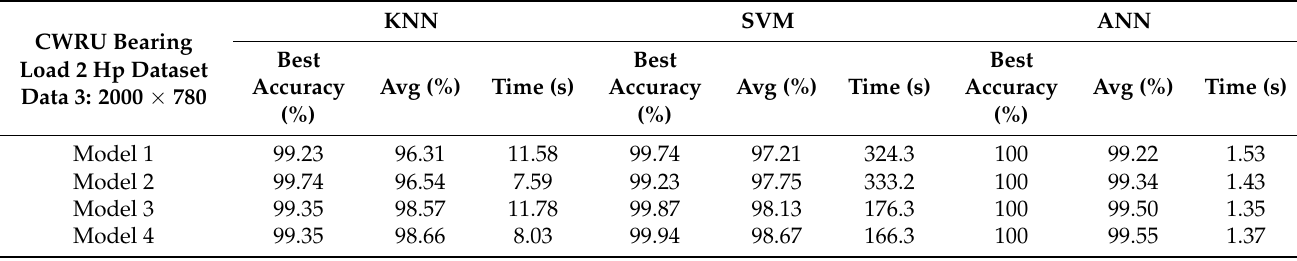
Table 8. Result in CWRU bearing load 2 Hp dataset.